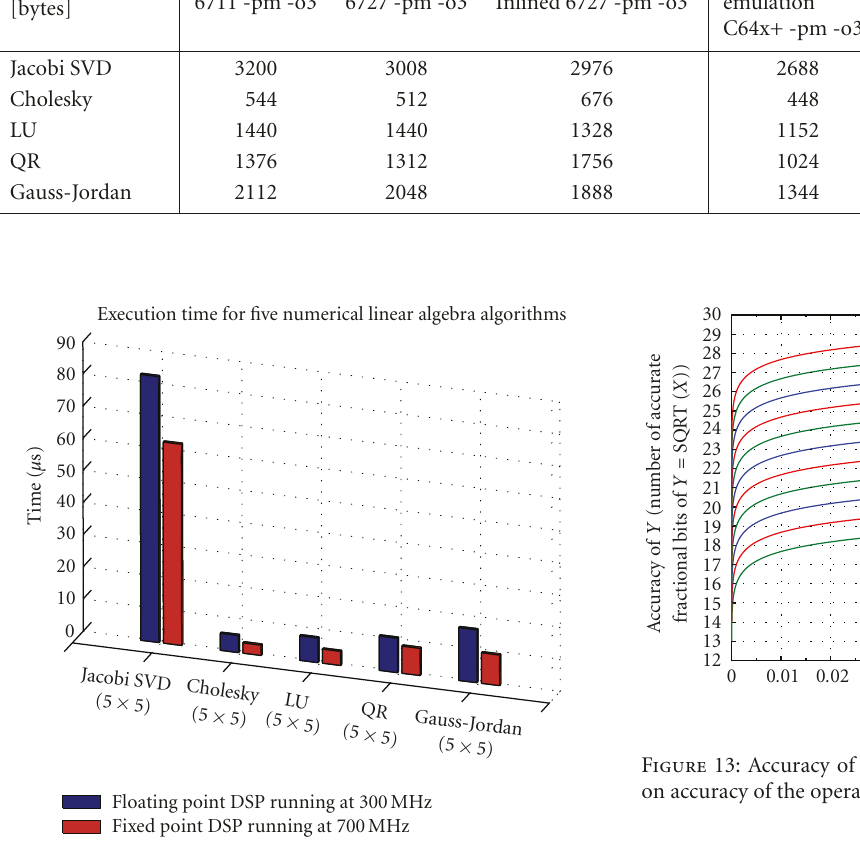
Figure 12: Execution time on floating point C67x+ CPU running at 300 MHz and on C64x+ CPU running at 700 MHz.